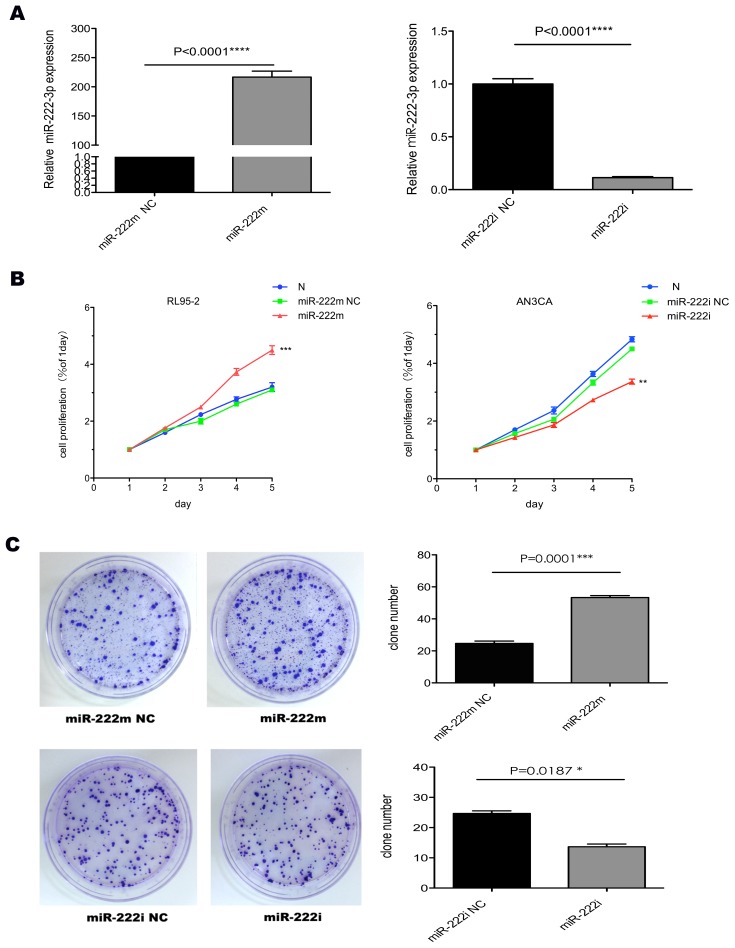
Transfection efficiency and cell proliferation after miR-222-3p expression changes.(A) qRT-PCR in RL95-2 and AN3CA cells after enforced and silenced expression of miR-222-3p for 48 h. (B) Cells with different miR-222-3p expression level were assayed for proliferation by MTT method at various time points. (C) Overexpression of miR-222-3p led to a significant increase in anchorage-independent colony forming ability of RL95-2 cells. Colony formation (≥50 cells) was assessed using a colony counter. Knockdown of miR-222-3p led to a decrease in anchorage-independent colony forming ability of AN3CA cells. * P<0.05, ** P<0.01, *** P<0.001, **** P<0.0001.